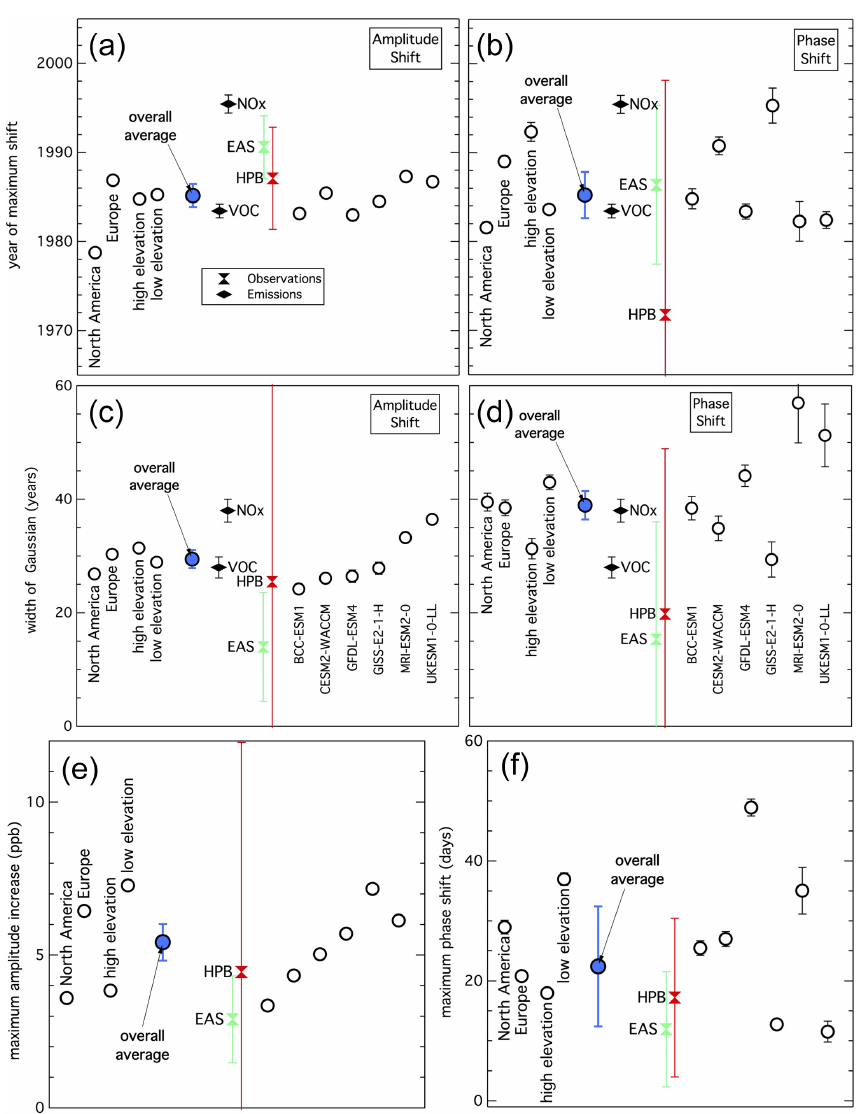
Figure 8. Summary of the simulated and measured ozone seasonal cycle shift analysis. The left and right graphs illustrate the shifts in the amplitude and phase of the seasonal cycle, respectively, for the year of maximum shift (a and b) , the half-width of the Gaussian function fit to the shifts (c and d) and the maxima of the shifts (e and f) . Circles indicate weighted averages of the parameters derived in all fits: the blue filled circle is the average for all six models at all six locations, the six-location averages for each model are to the right, and the six-model averages for three locations selected for continent or elevation are to the left. Parameters derived from fits to observations at the European alpine sites (EAS) and Hohenpeissenberg (HPB) as well as for VOC and NO x emissions are included near the center of each graph using the annotated symbols. Error bars indicate confidence limits for all symbols, although many are covered by the symbols